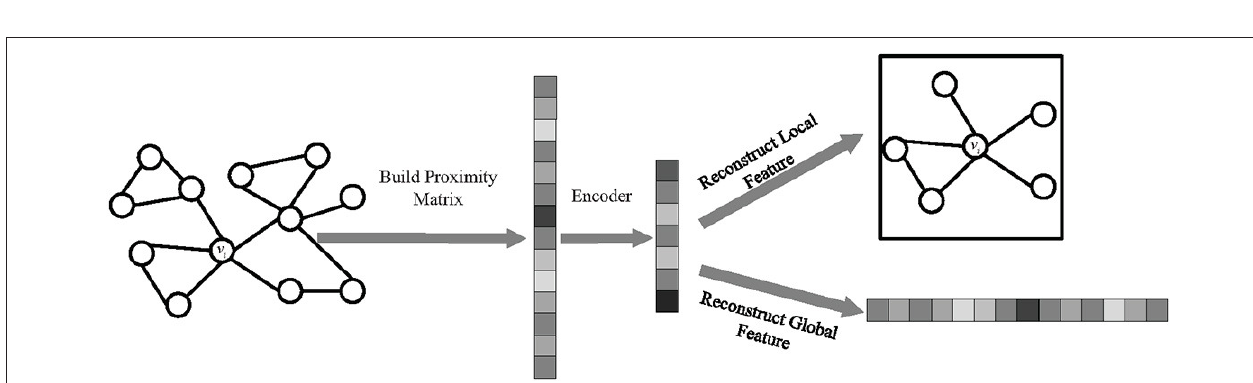
Algorithm 1: Framework of the proposed MLNE